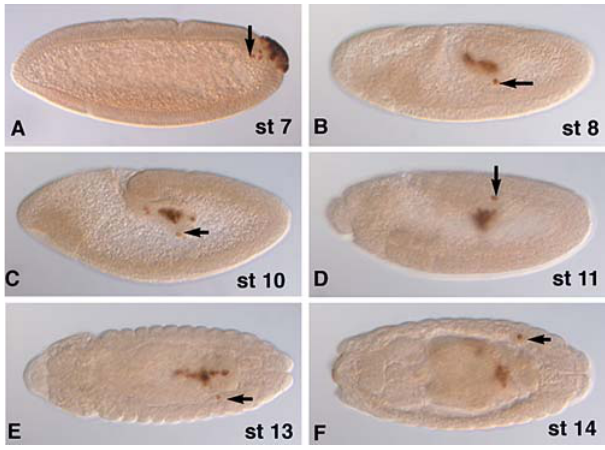
Figure 7. tre1 Germ Cells Can Migrate to the Gonad (A–F) tre1 embryos labeled with anti-Vasa to mark germ cells. Anterior is left. Embryos in (A)–(D) are lateral views, and embryos in (E) and (F) are top views. Arrows point to the few germ cells that migrate correctly. Arrows in (A) and (B) point to a few germ cells that are clearly on the basal side of PMG anlage (on average, 1.27 germ cells per embryo). Arrow in (C) points to germ cells on the basal side of the PMG (on average, 1.47 germ cells per embryo). The arrow in (D) points to a germ cell that migrated successfully into the mesoderm. Arrows in (E) and (F) mark single germ cells that reached the embryonic gonad (on average, 1.2 germ cells per embryo). DOI: step that allows them to pass through the PMG epithelium,